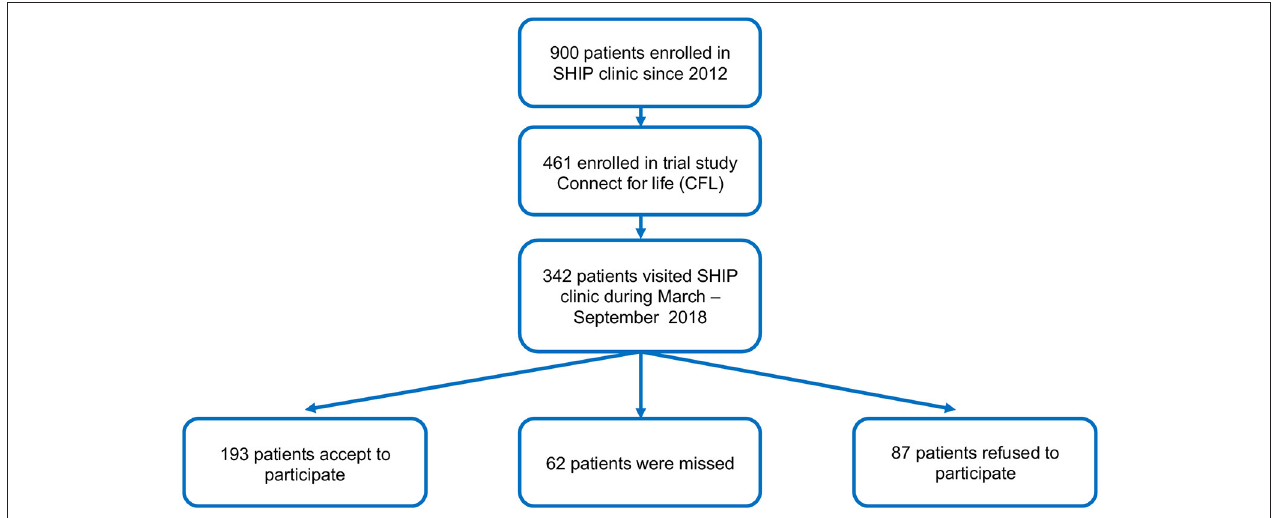
FIGURE 1 | Study participant